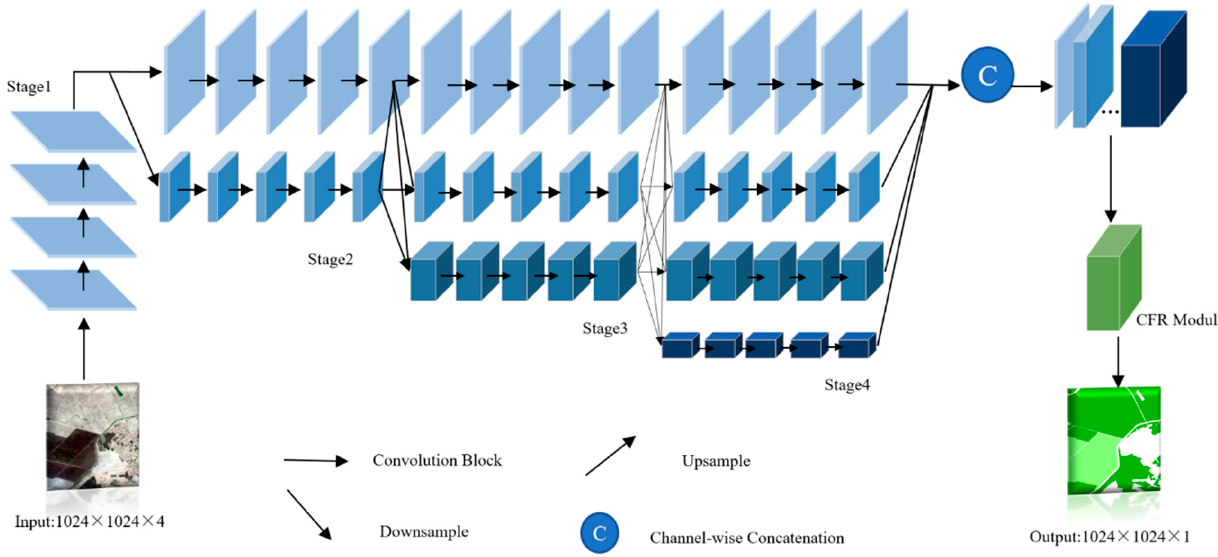
Figure 4. The network structure diagram of HRNet ‐ CFR.